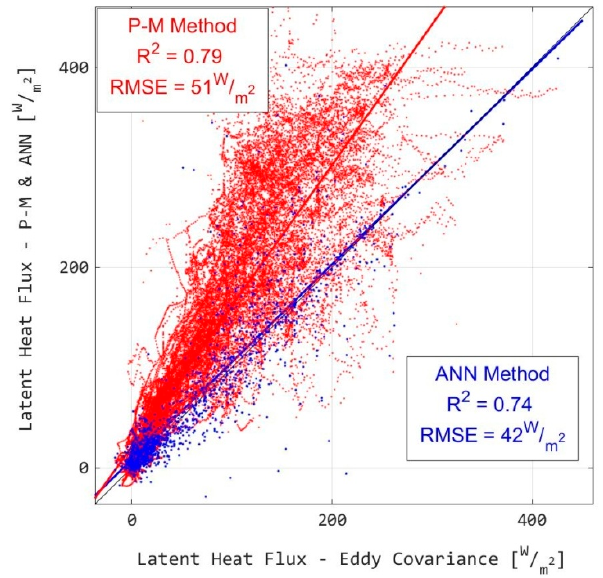
Figure 9. Method comparison for ET at site 2 (hazelnut orchard) resulting from two week training